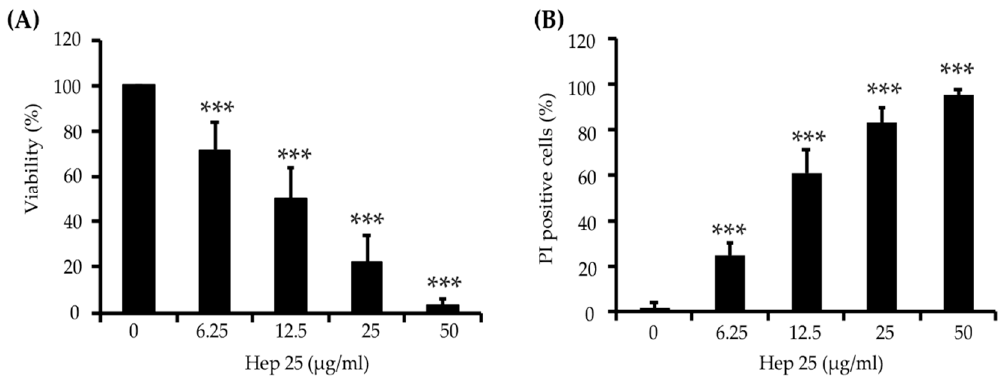
Figure 1. C. albicans killing assay of hep 25. ( A ) Killing of C. albicans by hep 25 was determined by the number of CFUs and expressed as the percentage of viable cells; *** p < 0.001. ( B ) The killing activity of hep 25 was detected by PI staining. The cells killed by hep 25 (PI-positive cells) were quantified by flow cytometry and reported as a percentage. The results are presented as the mean ± standard deviation of three independent experiments; *** p < 0.001.